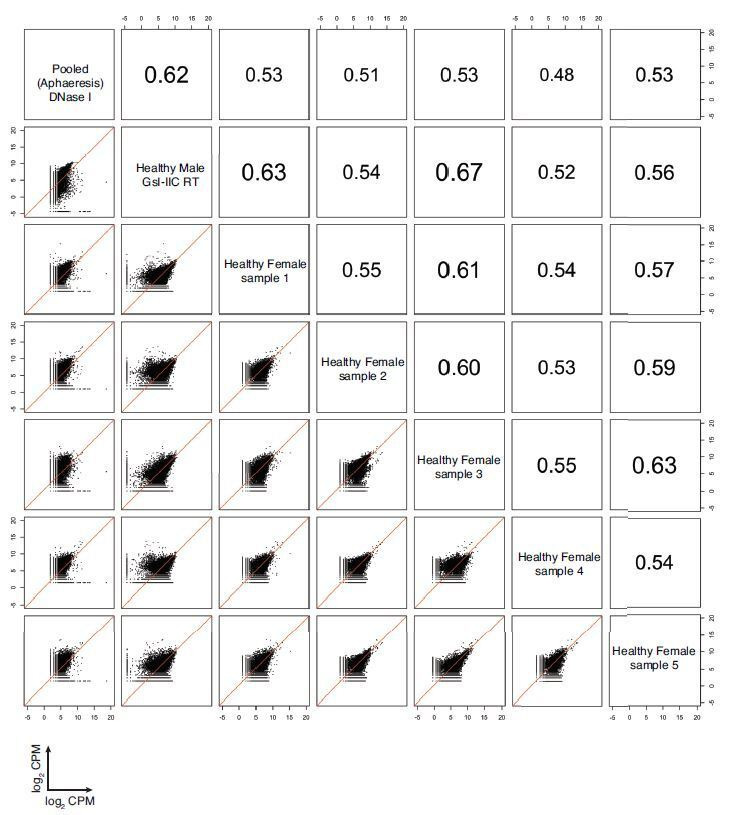
Correlation matrix of protein coding genes detected in DNase I-treated pooled plasma RNA using the improved TGIRT-seq method in this work (n=12), previously by TGIRT-seq in DNase I-treated plasma RNA from a healthy male individual (n=3; SRP064378, datasets 12-14) (Qin et al., 2016), and healthy plasmas samples similarly prepared from five healthy females in a collaborative study with Dr. Naoto Ueno, M.D. Anderson.For comparisons, CPMs for each gene in a dataset were normalized to the total number of mapped reads in that dataset, log2 transformed, and plotted. Spearman correlation coefficients are shown on the upper triangle. Numbers on the x and y axes of scatter plots are log2 transformed CPMs.